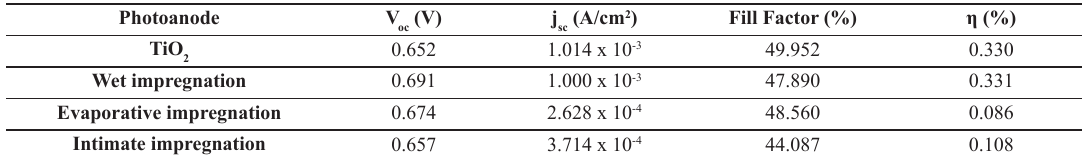
Table 7. j x V curve results of cells with Au nanoparticles supported via different impregnation methods.